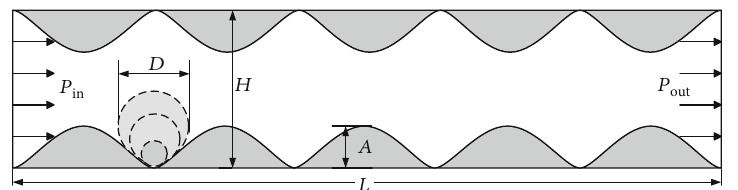
Figure 6: Schematic of fl ow around a circular particle close to an irregular wall.